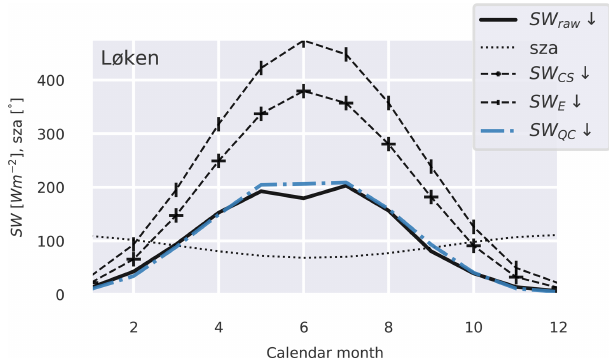
Figure 2. Estimated and measured shortwave radiation (Wm − 2 ) at Løken station (61.1 ◦ N, 9.1 ◦ E) for the period January 1991 to December 1999. Mean monthly solar zenith angle (SZA), (global) shortwave incident radiation at the top of the atmo- sphere (SW E ↓ ), modeled clear-sky incident shortwave radiation SW CS ↓ ), and station measurements of incident shortwave radiation before (SW raw ↓ ) and after (SW QC ↓ ) quality control are